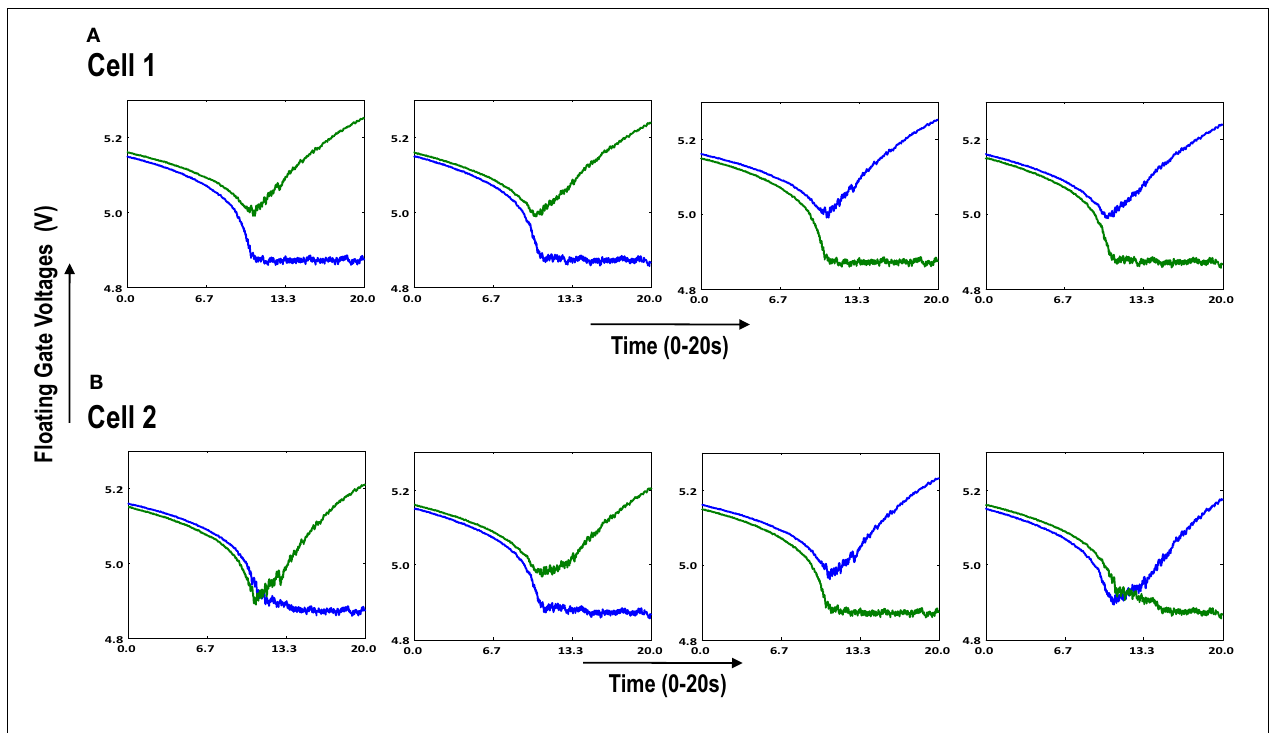
FIGURE 6.3 | Shows the development of floating gate voltages of the diffusively coupled cortical cells in Figure 6.1B. Cell 1 which seems to have a stronger bias influences the development of Cell 2 which modifies its